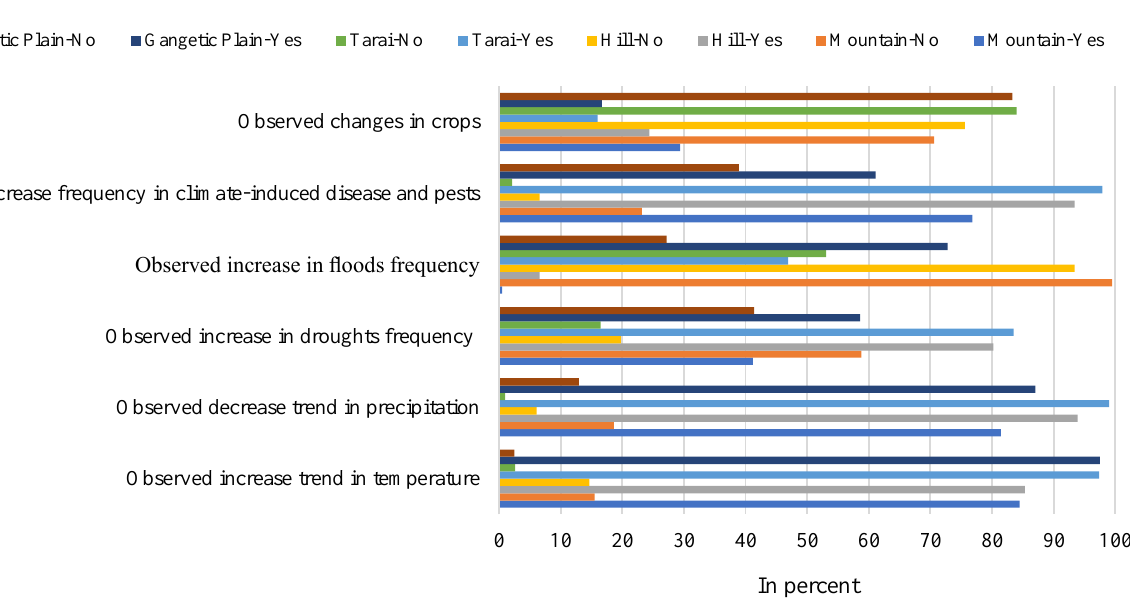
Figure 6. The observed indicators of climate change by local farmers in four physiographic regions of the trans-boundary KRB.